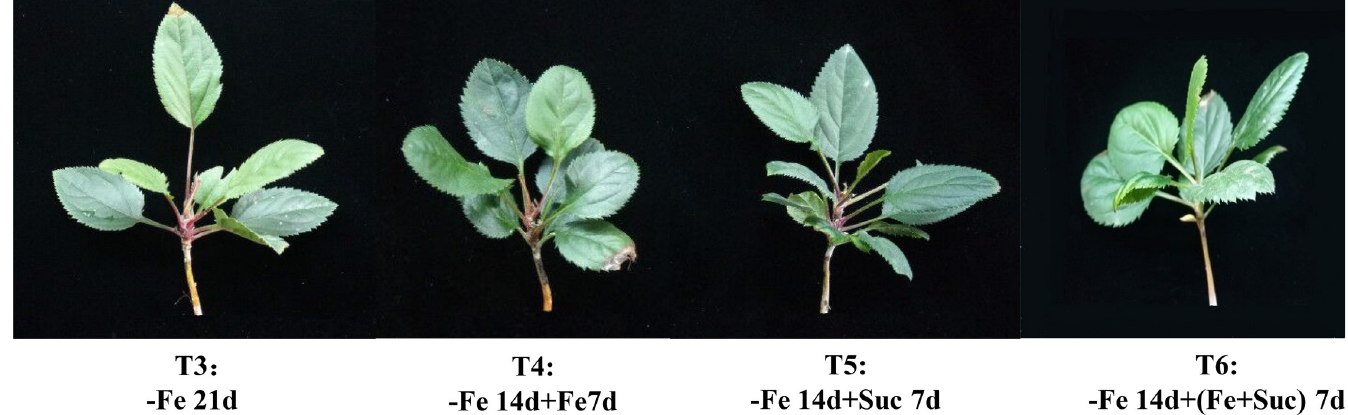
Fig 3. Effects of exogenous Suc on the phenotype of leaves from M . halliana . T3: -Fe 21 d (Fe deficiency 21 d). T4: -Fe 14 d + Fe 7 d (applied Fe after 14 d of Fe deficiency). T5: -Fe 14 d + Suc 7 d (applied Suc after 14 d of Fe deficiency). T6: -Fe 14 d+ (Fe + Suc) 7 d (applied Fe and Suc after 14 d of Fe deficiency).